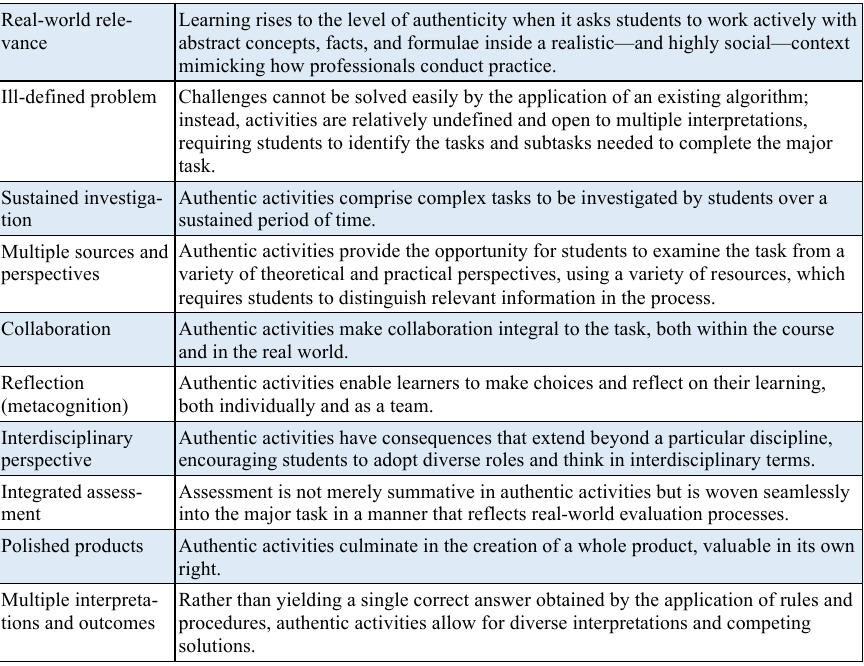
Table 1. Authentic teaching and learning design